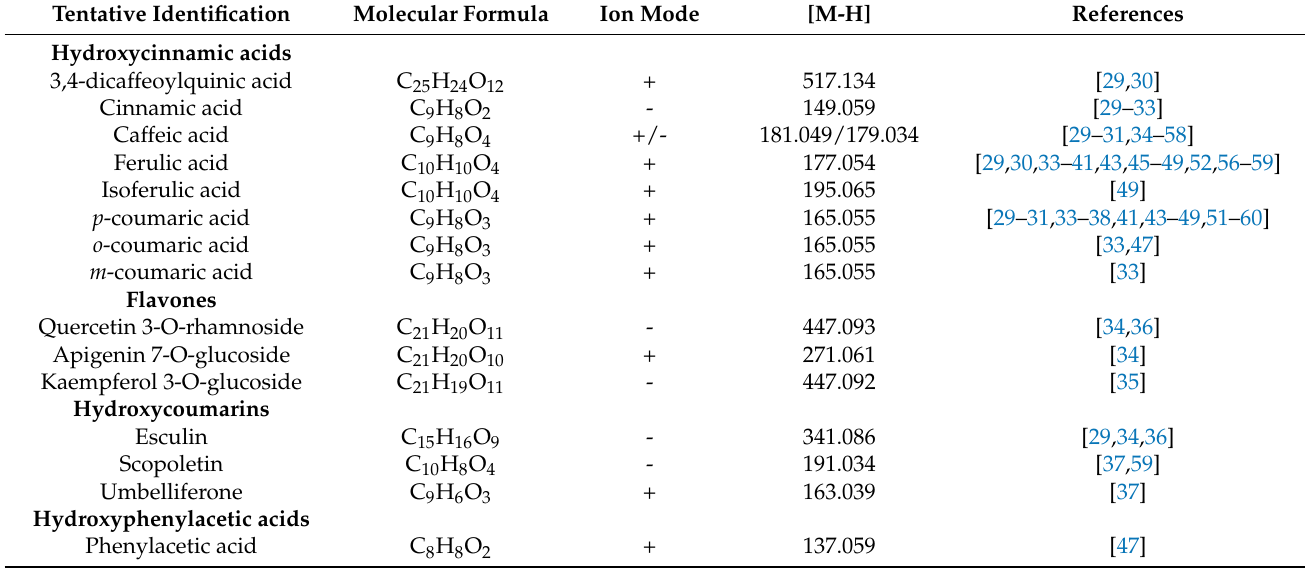
Table 3. Phenolic compounds identification in the extract of avocado